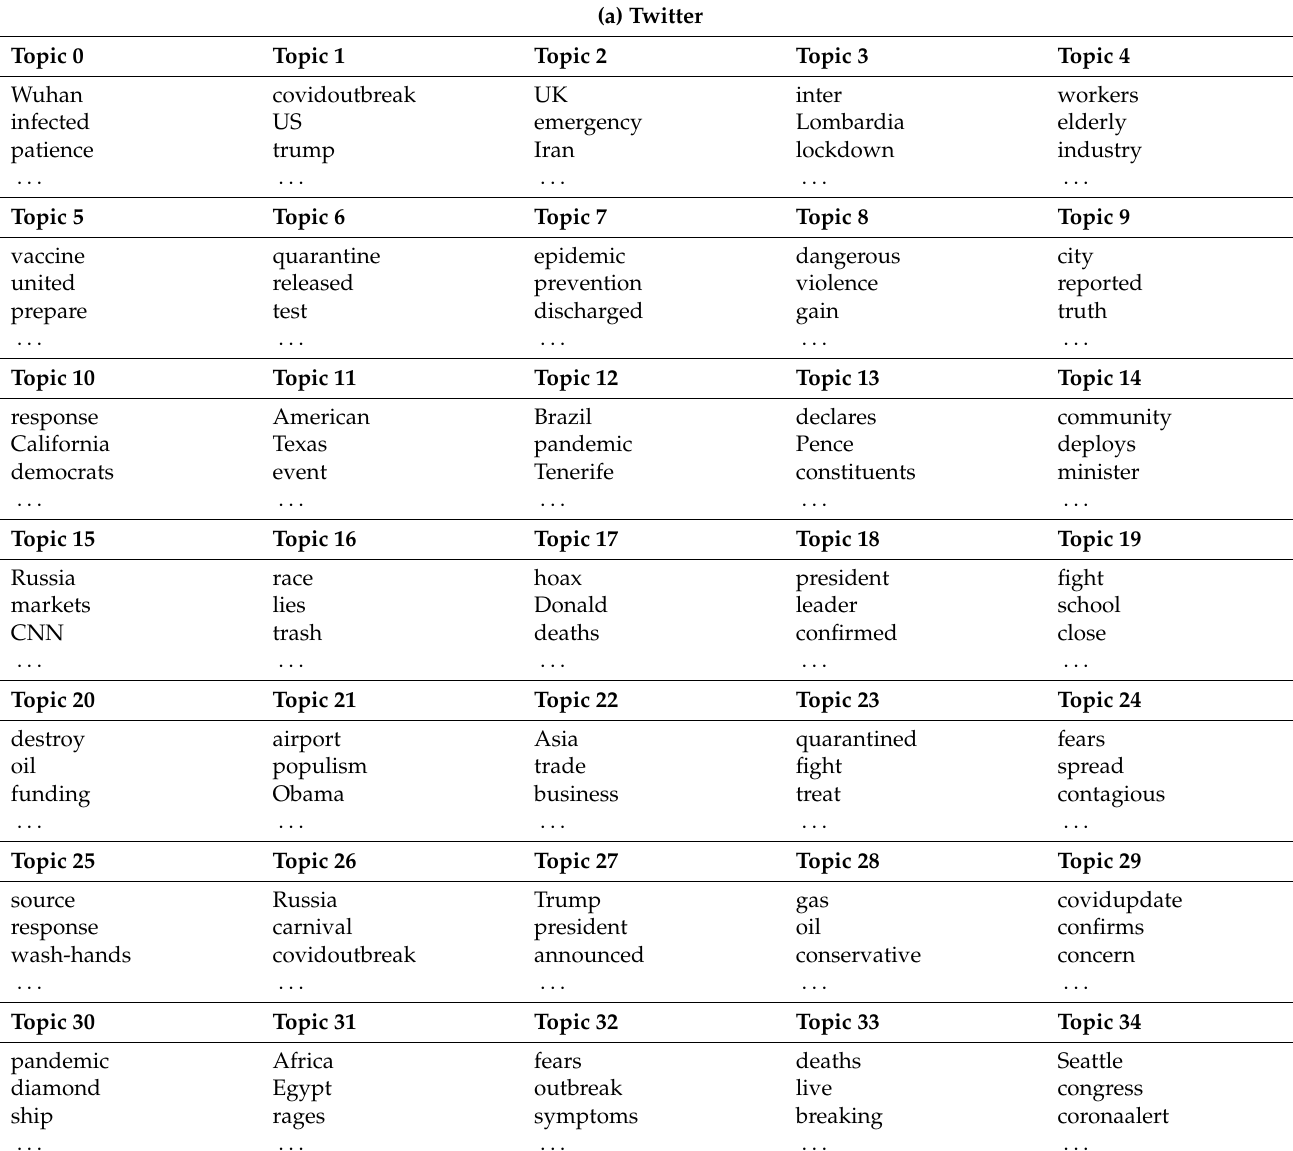
Table 1. Twitter and Weibo topics and